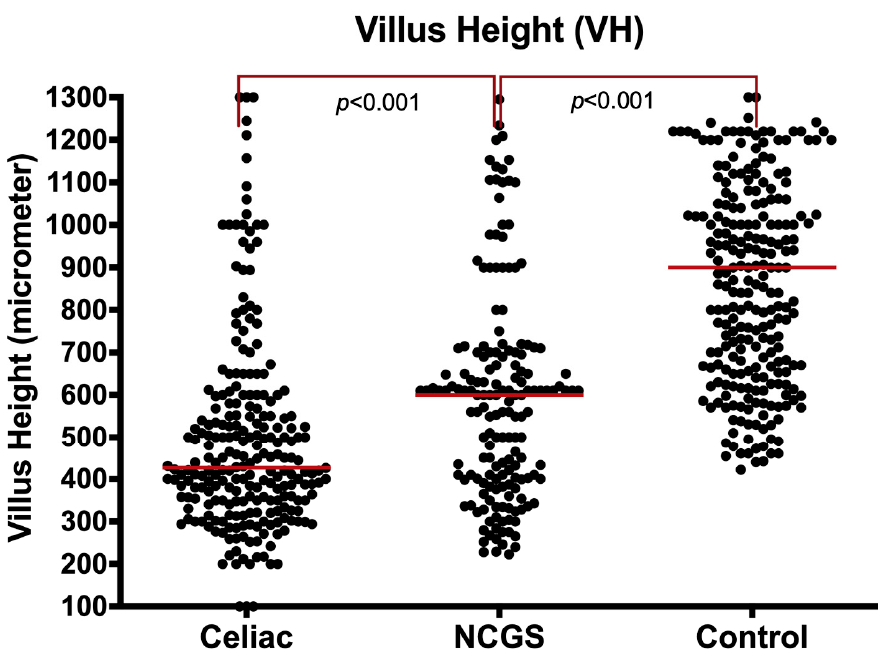
Figure 1. Villus height ( µ m) in NCGS compared to CeD and controls, entire cohort.